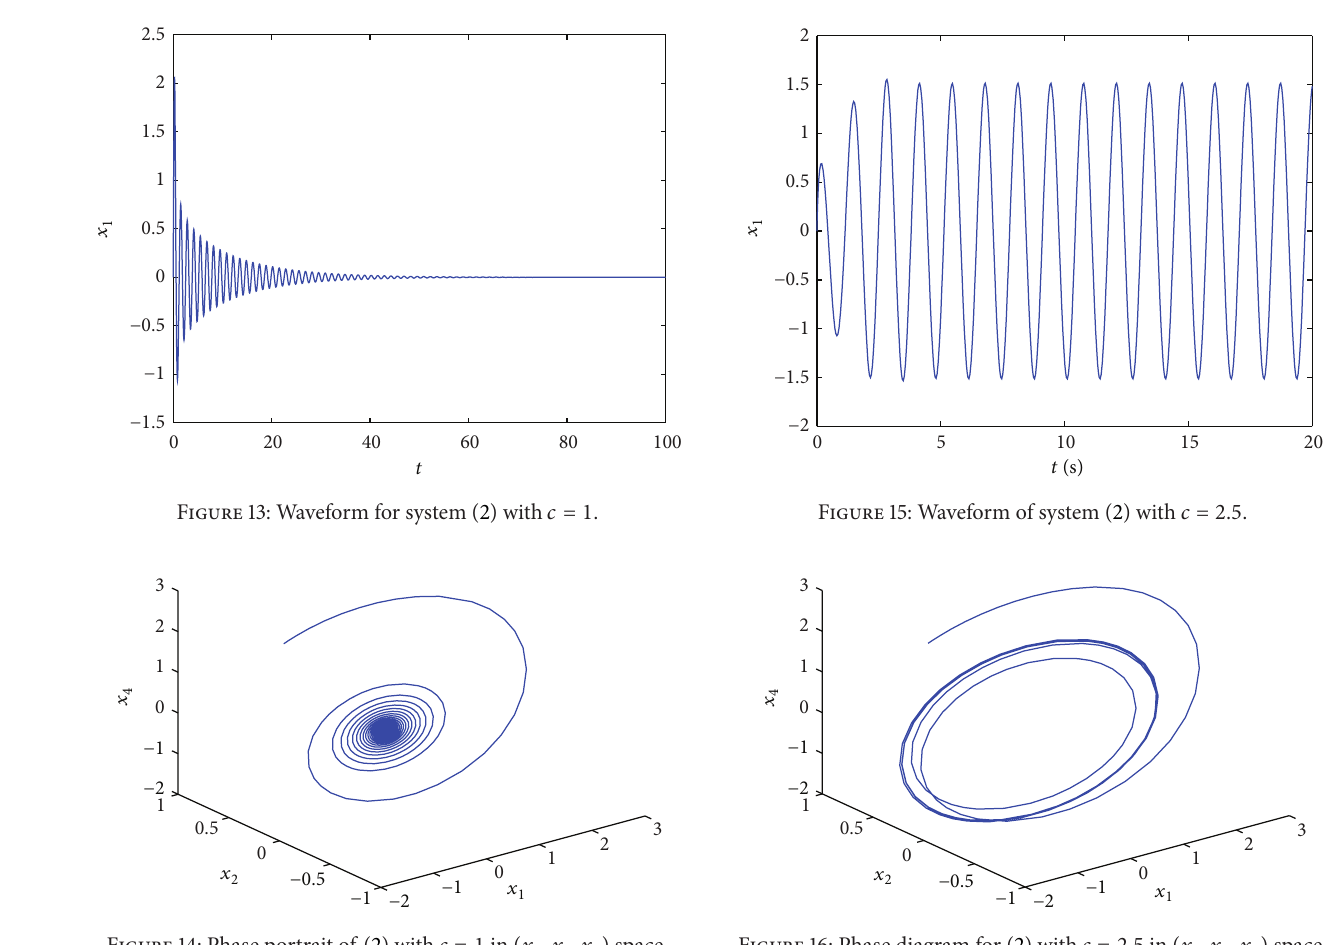
Figure 16: Phase diagram for (2) with 𝑐 = 2.5 in ( 𝑥 1 , 𝑥 2 ,𝑥 4 )